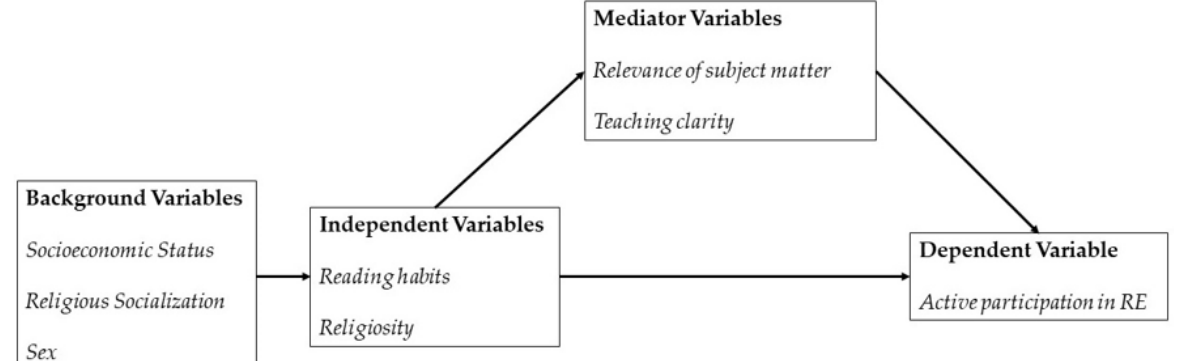
Figure 1. Conceptual model of unequal learning opportunities in RE.